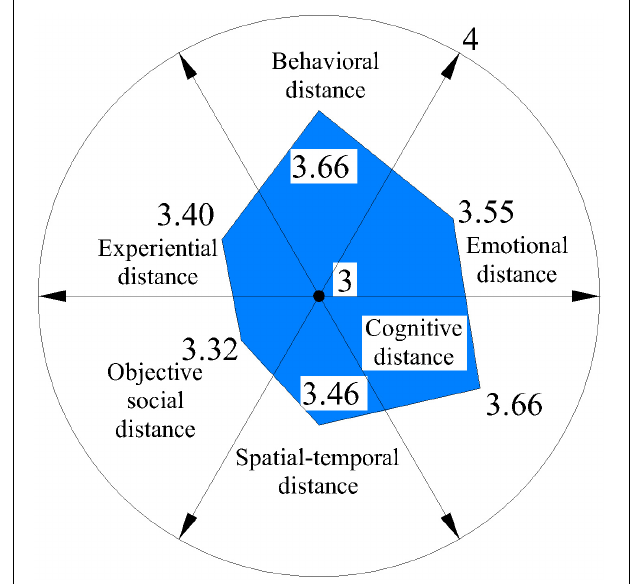
FIGURE 3 | Average psychological distance distribution on integrated relationship.